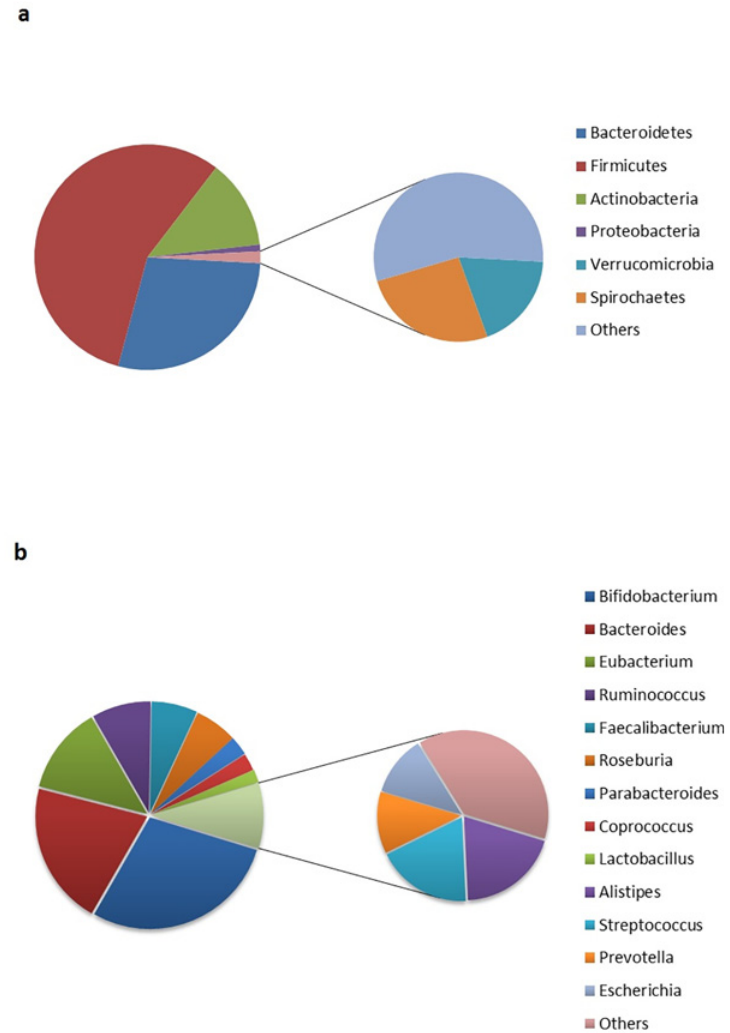
Firmicutes phylum, like Roseburia, Faecalibacterium, Ruminococcus and Eubacterium, were observed to harbor these CAZyme families, two genera, namely Bifidobacterium (belonging to Actinobacteria) and Bacteroides (belonging to Bacteroidetes) accounted for almost half the proportion of such CAZymes.